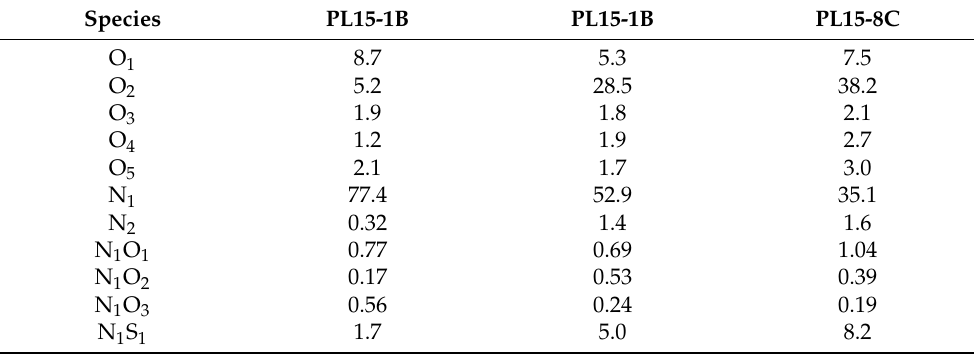
Table 2. Relative abundance of heteroatomic compound classes in the studied crude